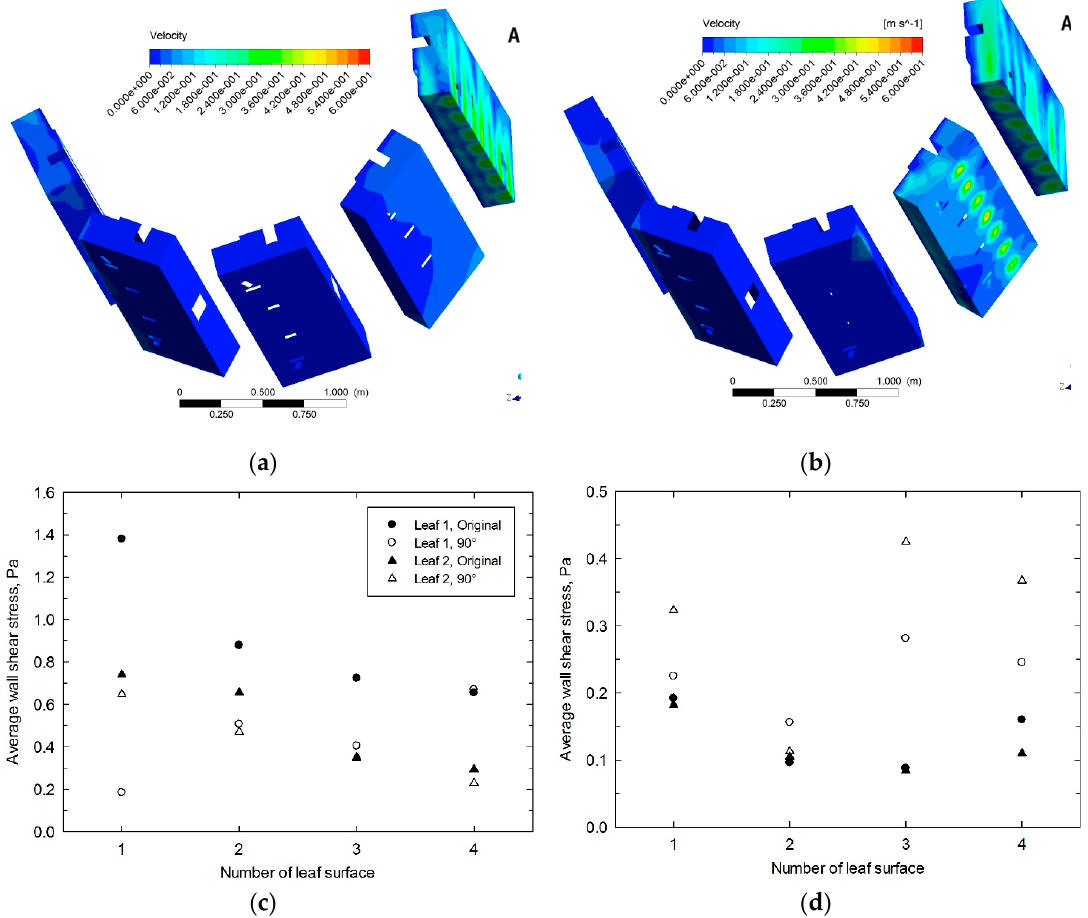
Figure 17. Computed velocity maps at face areas but in perspective view for: ( a ) Original case and ( b ) nozzle rows at 90°. Inlet oil velocity was 0.5 m/s. Comparison of average wall shear stress in ( c ) box 1 and ( d ) box 2 computed in each leaf surface face, 1 = front, 2 = inferior, 3 = superior and 4 = back.